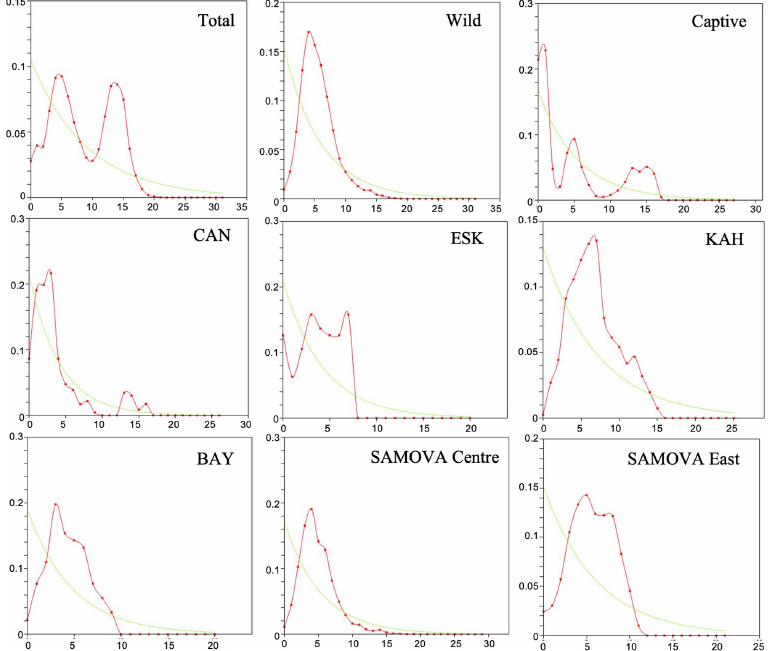
Figure 4. Mismatch distribution of Chukar Partridges based on SAMOVA groups. Pairwise differences of observed (red) and expected (green) values under the demographic expansion model.